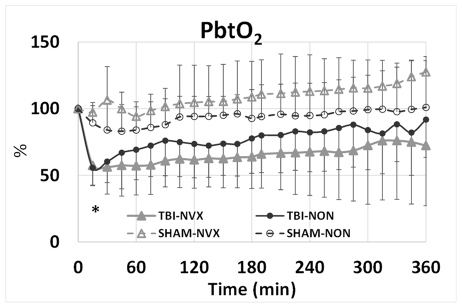
Figure 3. Brain tissue oxygenation (PtbO 2 ) for the TBI-NVX, TBI-NON, SHAM-NVX and SHAM-NON groups. * p < 0.01; significant difference between TBI vs. SHAM (effect due to trauma). Mean and standard deviation; SHAM-NON (-- ○ --), SHAM-NVX (-- ∆ --), TBI-NON ( ─ ● ─ ), TBI-NVX ( ─▲─ ).